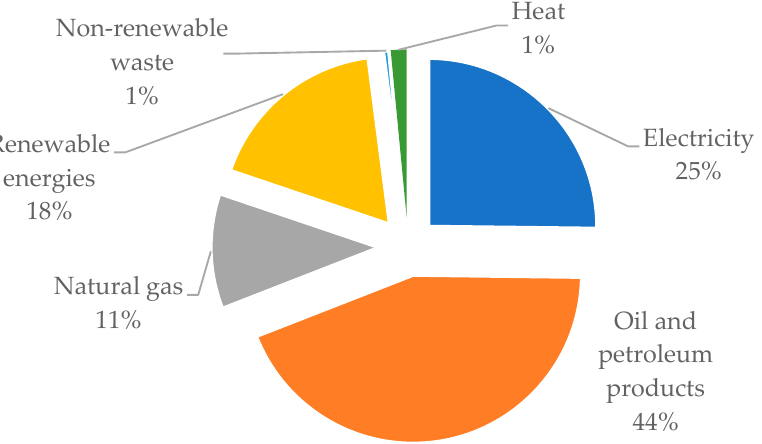
Figure 20. Fuels going through final energy consumption–2019 data (adopted from Eurostat data).